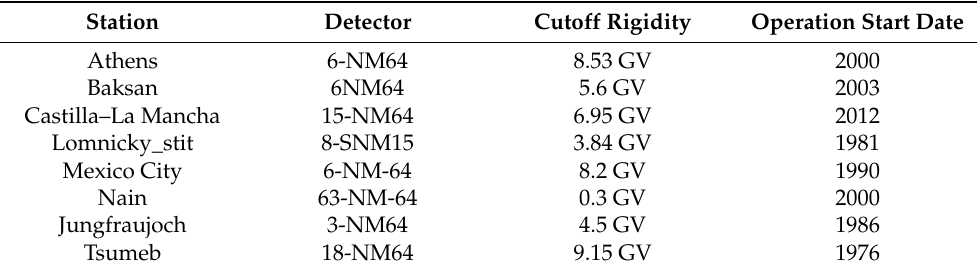
Table 2. Detectors used and cutoff rigidity values.